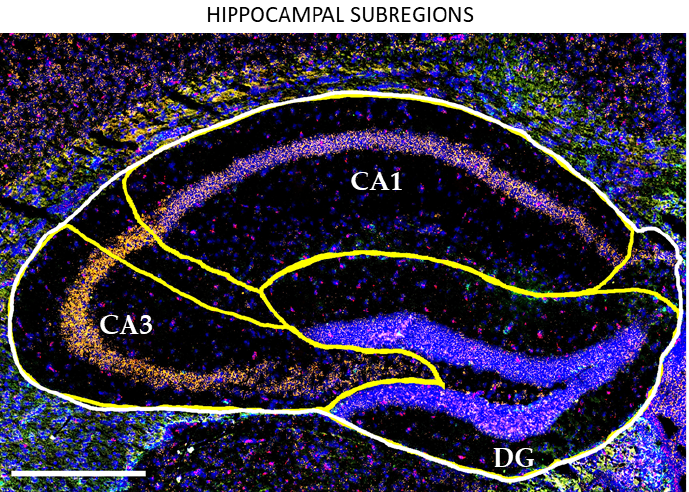
Figure 2. Hippocampal subregions involved in memory acquisition. Representative in situ hybridization image of the hippocampus outlining the regions of the hippocampus which are integral to declarative memory. The dentate gyrus (DG) and CA3 subregions receive cortical input from the entorhinal cortex (ETC—not shown) and then synapse onto the CA1. The CA1 integrates inputs an then processes information through the subiculum and ETC for storage. Scale bar = 500 μ m; in situ hybridization of mRNA: blue = DAPI; orange = Ldha ; red = Glut1 ; green = Gfap .